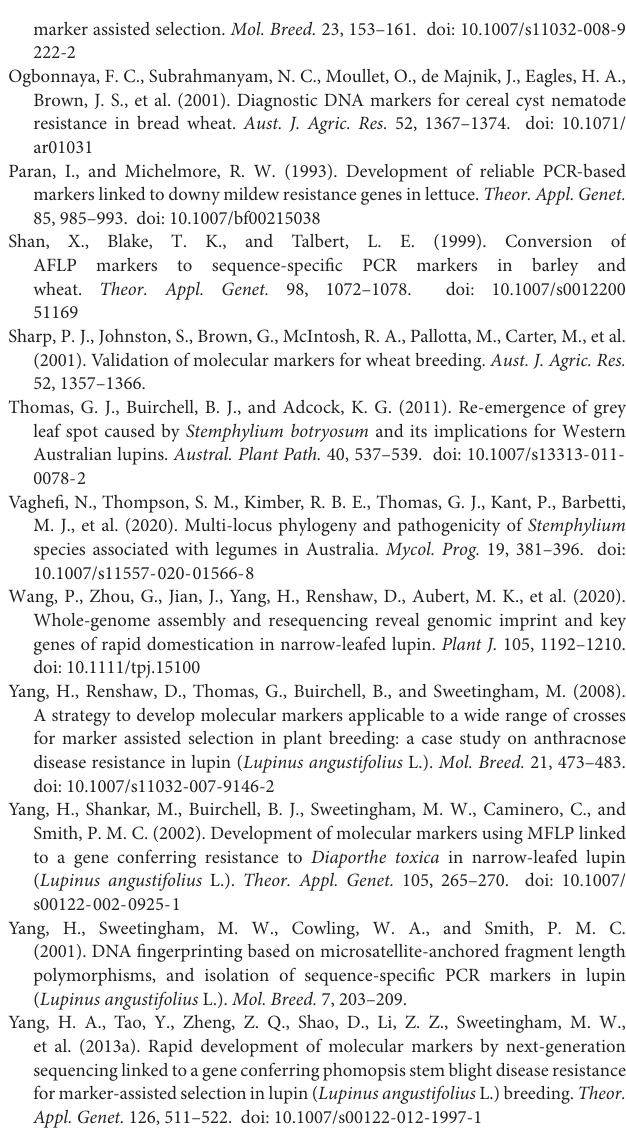
Supplementary Figure 1 | QTL for gray leaf spot disease resistance in narrow-leafed lupin (Threshold LOD = 3). Supplementary Table 1 | MFLP marker amplicon